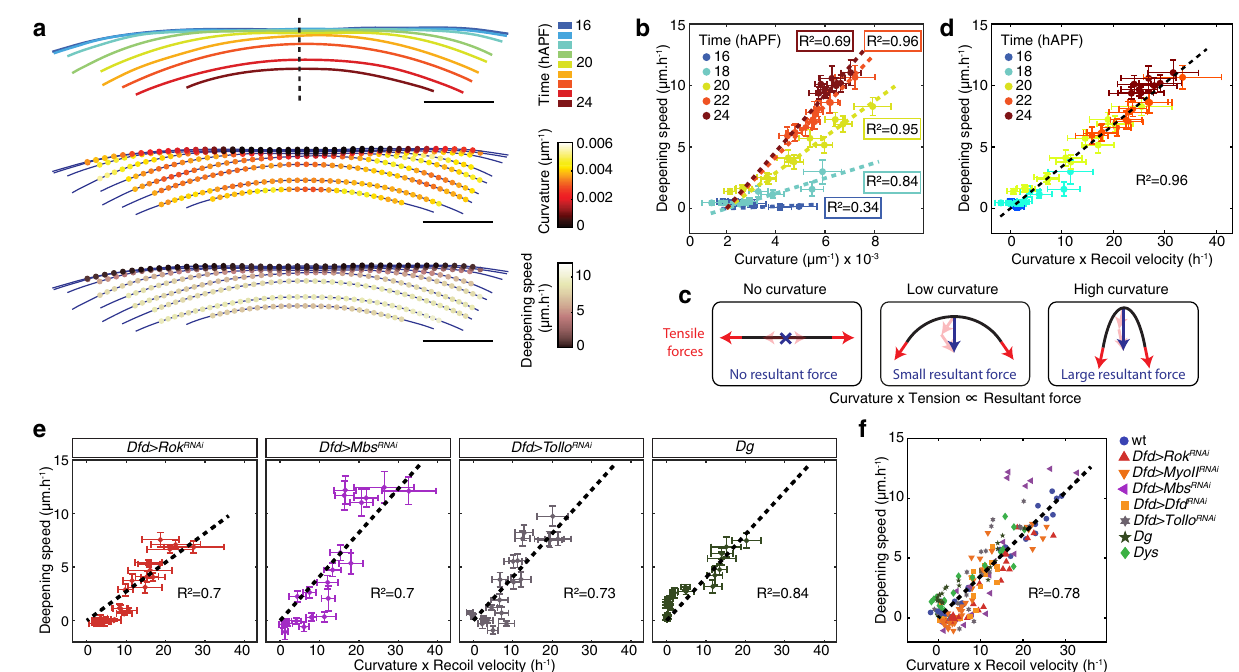
Fig. 5 | The product of local tissue curvature and ML tension can account for neckfoldingdynamics.a Successivepositionsoftheapicalfoldfront,color-coded accordingtotime(top),localtissuecurvature(middle),andlocaldeepeningspeed (velocityalongthevectornormaltothecurve)oftheapicalfoldfront(bottom)for anindividualpupa.Dashedline,midlineposition.SeealsoSupplementaryMovie4. b Graph of the apical fold front deepening speed (mean±sem) versus curvature (mean±sem).Eachpointisthe meanvalue(±sem)among 10controlanimals fora given Position ML at a given color-coded developmental time. For each develop- mental time, a line passing through the origin was fi tted ( R 2 values for each developmental time are indicated). c Schematic illustrating that the tissue line tensionandthelocaltissuecurvaturede fi nethemagnitudeofthenormalresulting force(seetextandSupplementaryNotefordetails). d Graphoftheapicalfoldfront deepeningspeed(mean±sem)andoftheproductofcurvatureandMLapicalinitial